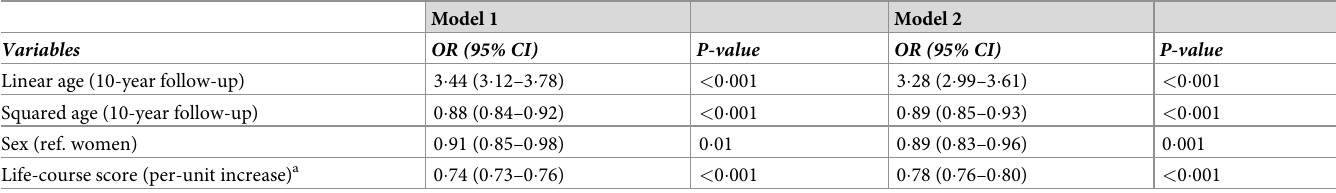
Table 3. Association of life-course socioeconomic circumstances (SECs) score with odds of multimorbidity at age 73 years. (N = 31,432). Model